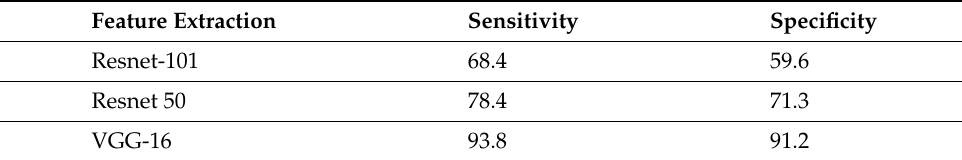
Table 6. Comparison of various deep learning models for feature extraction.